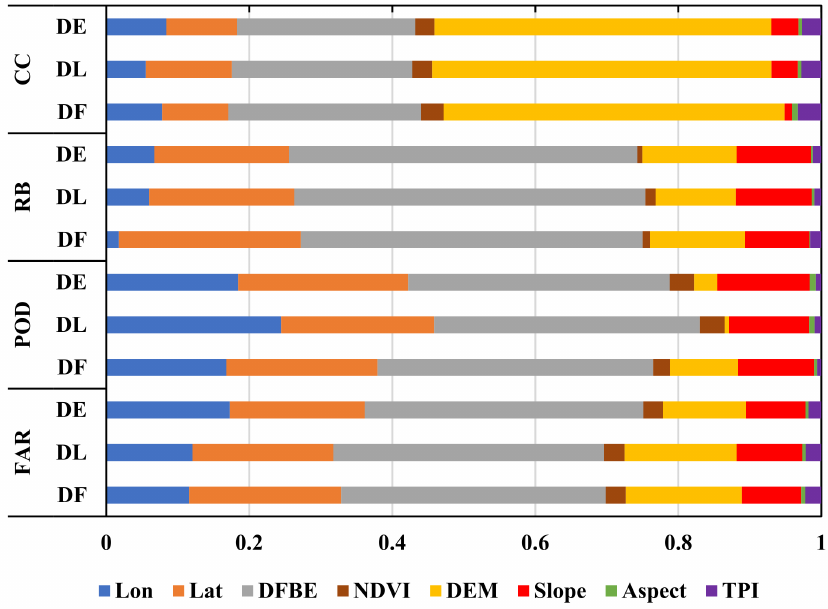
Figure 2. The weight distribution of regression coefficients is based on statistical error